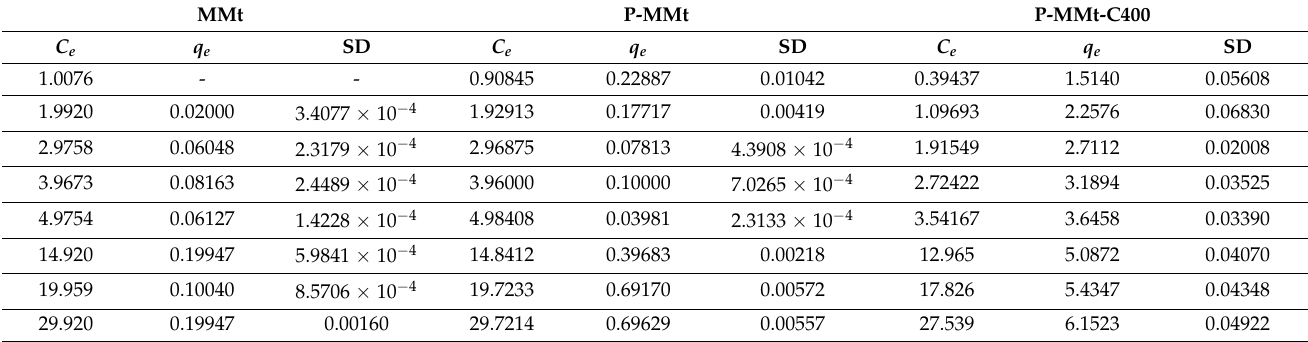
Table A3. The MO equilibrium adsorption capacities of MMt, P-MMt, and